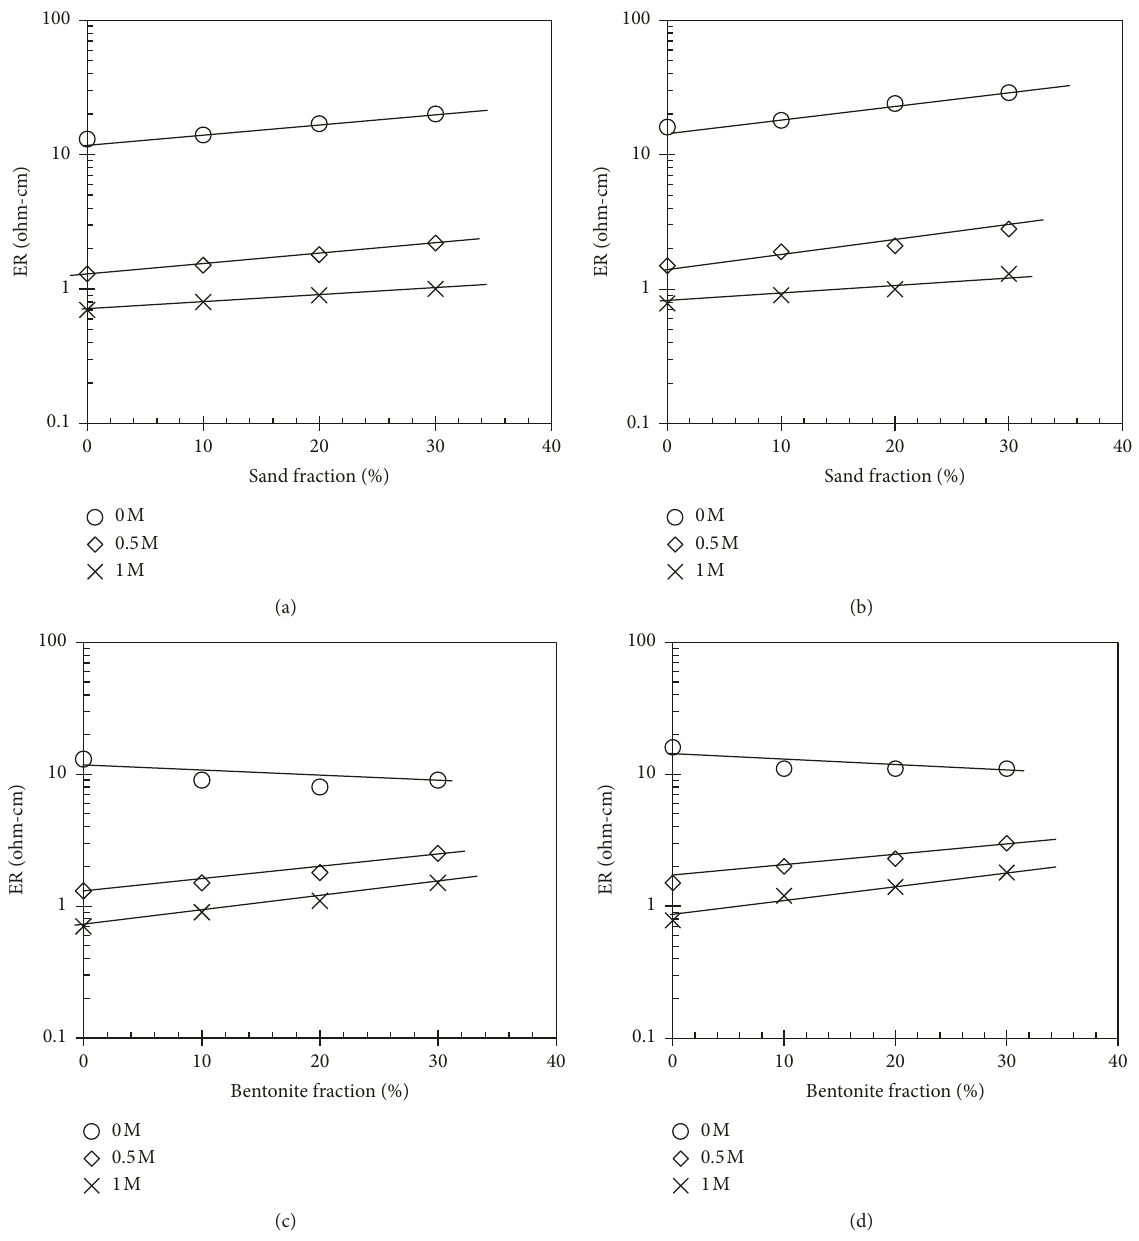
Figure 10: Comparisons of ER at two different dry densities (1.4 g/cm 3 and 1.6g/cm 3 ) for different sand/bentonite fractions at 20% water content. (a) W c